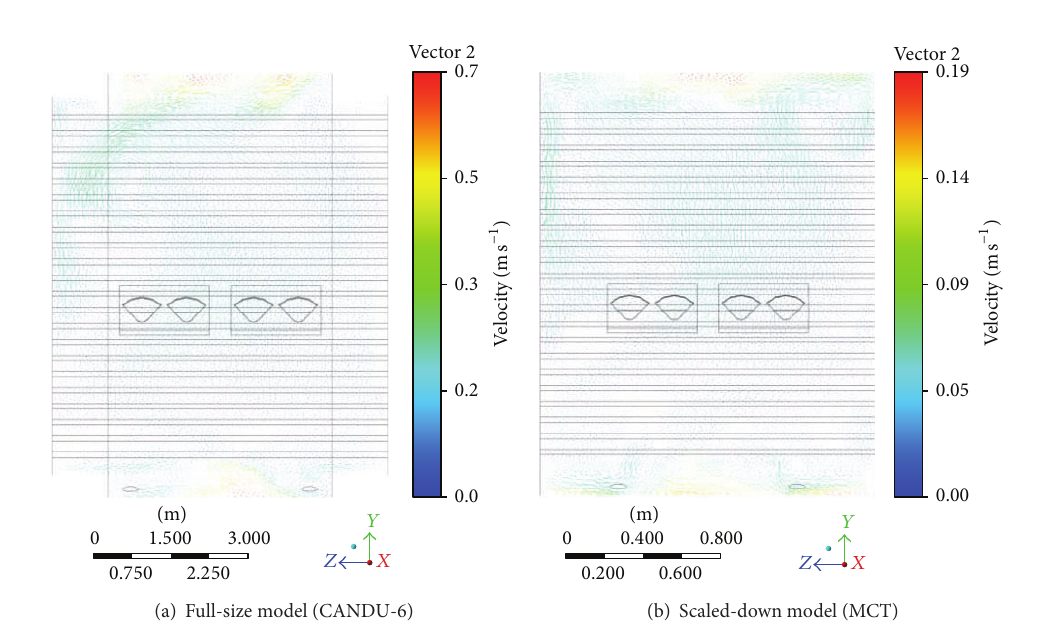
Figure 6: Velocity vector on the axial center plane.